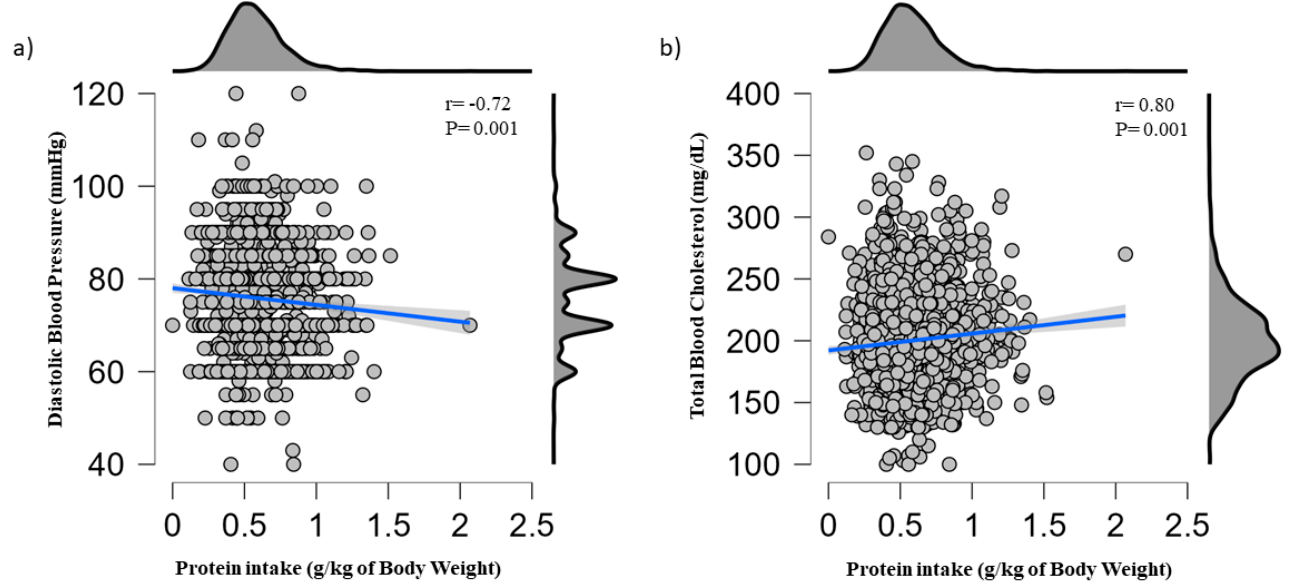
Figure 1. Scatter plot of the association between daily protein intake and ( a ) diastolic blood pressure and ( b ) total blood cholesterol.